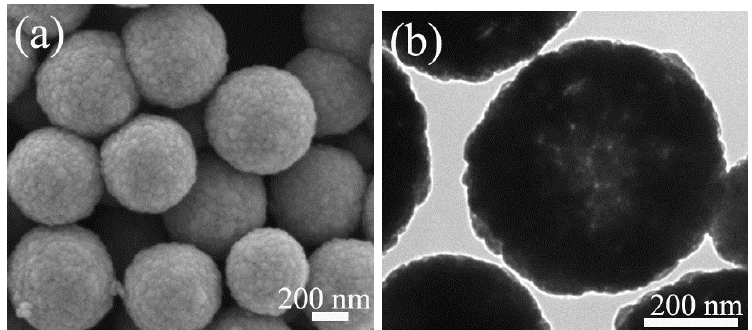
Figure 3. SEM images ( a ) and TEM images ( b ) of pure Fe 3 O 4 hollow microspheres.